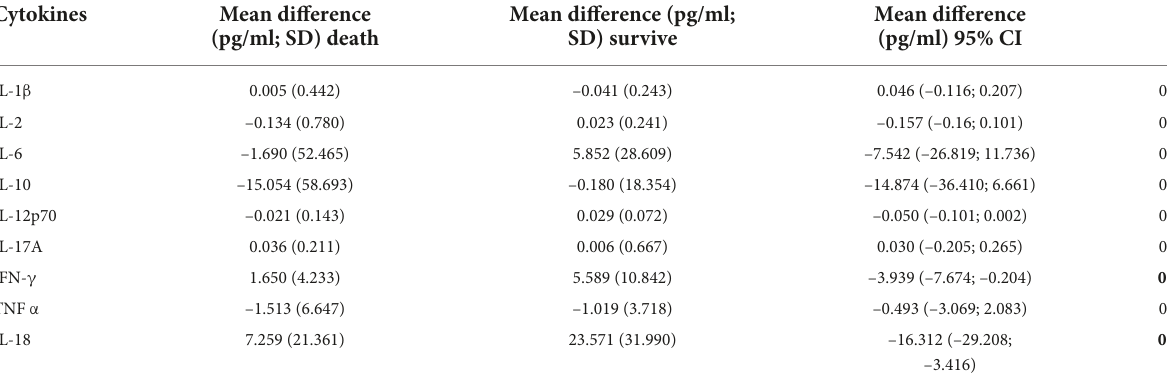
TABLE 3 Change in the mean difference between the serum levels cytokines between day 1 and day 7 with mortality.